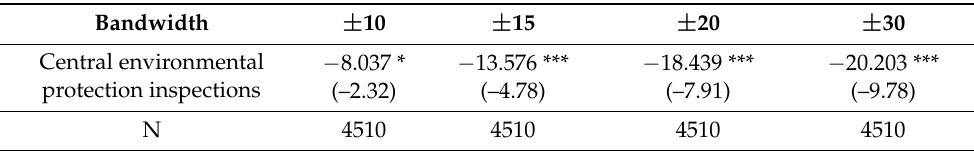
Table 2. Results of bandwidth